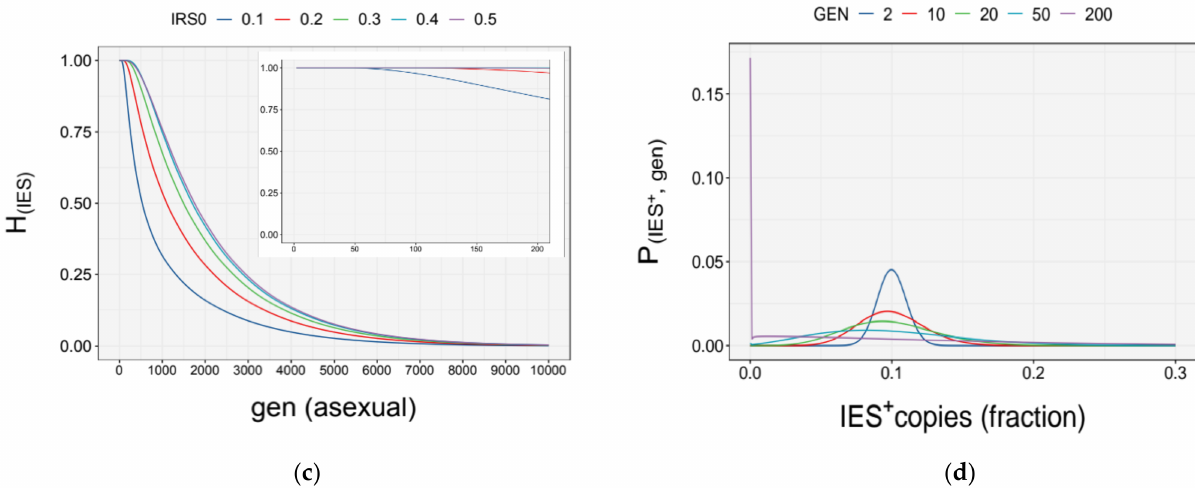
Figure 5. Simulations of somatic assortment for P. tetraurelia . ( a ) Probability distribution of IES + copies, P (IES + ; GEN). Simulated probability distribution of the number of IES + copies in the somatic nuclei after successive amitotic divisions (GEN = 40, 120, 200, 600). Cultivation days (D) are indicated in brackets. The number of IES + copies is expressed as a fraction of the ploidy (k = 860 (C)). Simulation is shown for IRS 0 = 0.5. The inset shows the probability surface across generations; ( b ) Effect of assortment on standard deviation, σ (IRS 0 ; GEN). Variability of the number of IES + copies due to somatic assortment. The rate of somatic assortment ( d σ /dt ) is the fastest at IRS 0 = 0.5 and decreases symmetrically around this value; ( c ) loss of heterozygosity, H . Probability of a locus to be in the heterozygous state across divisions. The inset shows the loss of H for an IES locus across a full clonal cycle of P. tetraurelia (average maximum lifespan of ~200 divisions [66]); ( d ) probability distribution of IES + copies, P (IES + ; GEN) across amitotic divisions (GEN = 2, 10, 20, 50, 200). Simulation is shown for IRS 0 = 0.1. Calculations are according to the haploid model . IRS 0 , starting retention levels. GEN, asexual generations. In ( b , c ), simulated values are identical for IRS 0 = [0.1 | 0.9; 0.2 | 0.8; 0.3 | 0.7; 0.4 |